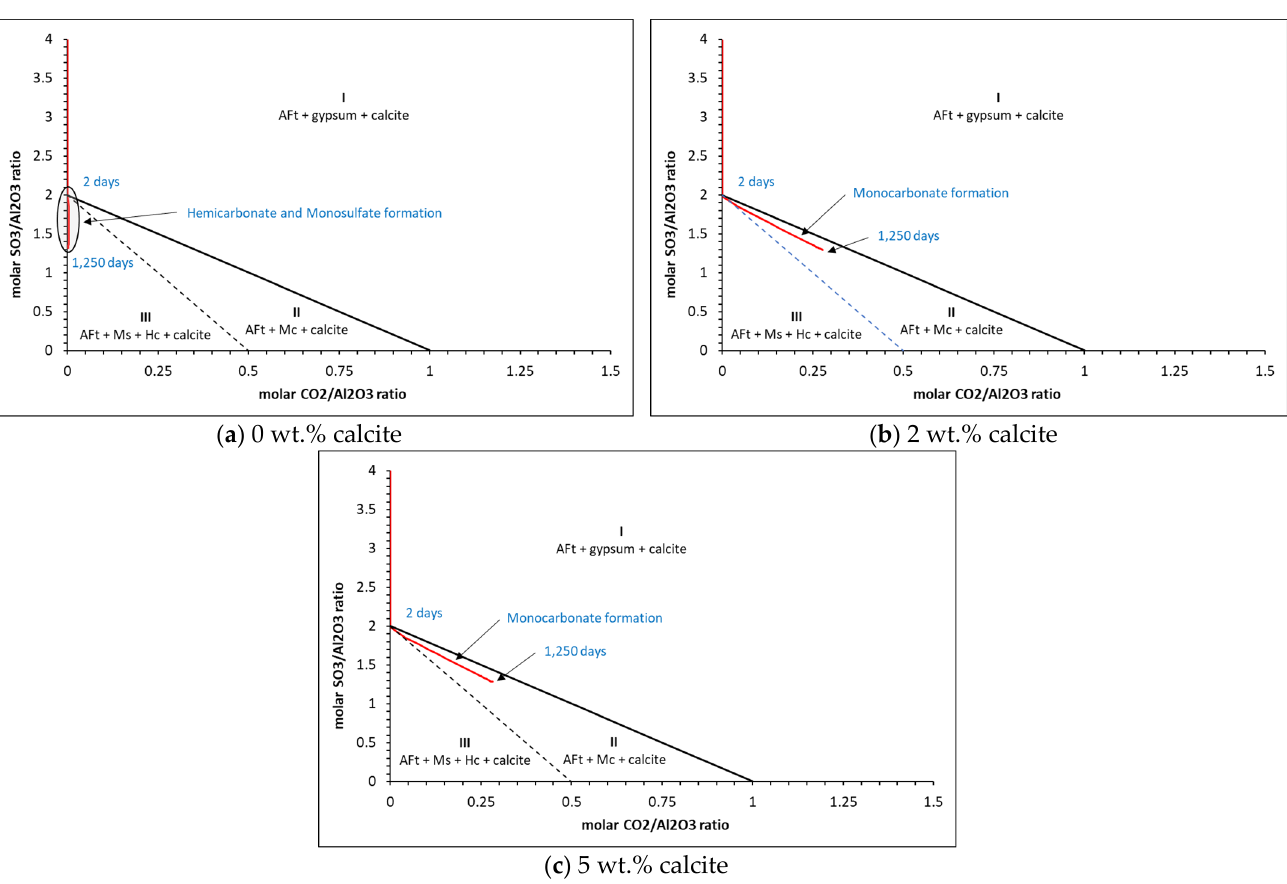
Figure 13. Thermodynamic predictions of carbonate and sulfate ratios for ( a ) 0%, ( b ) 2% and ( c ) 5% calcite for the w/c = 0.4 cement.